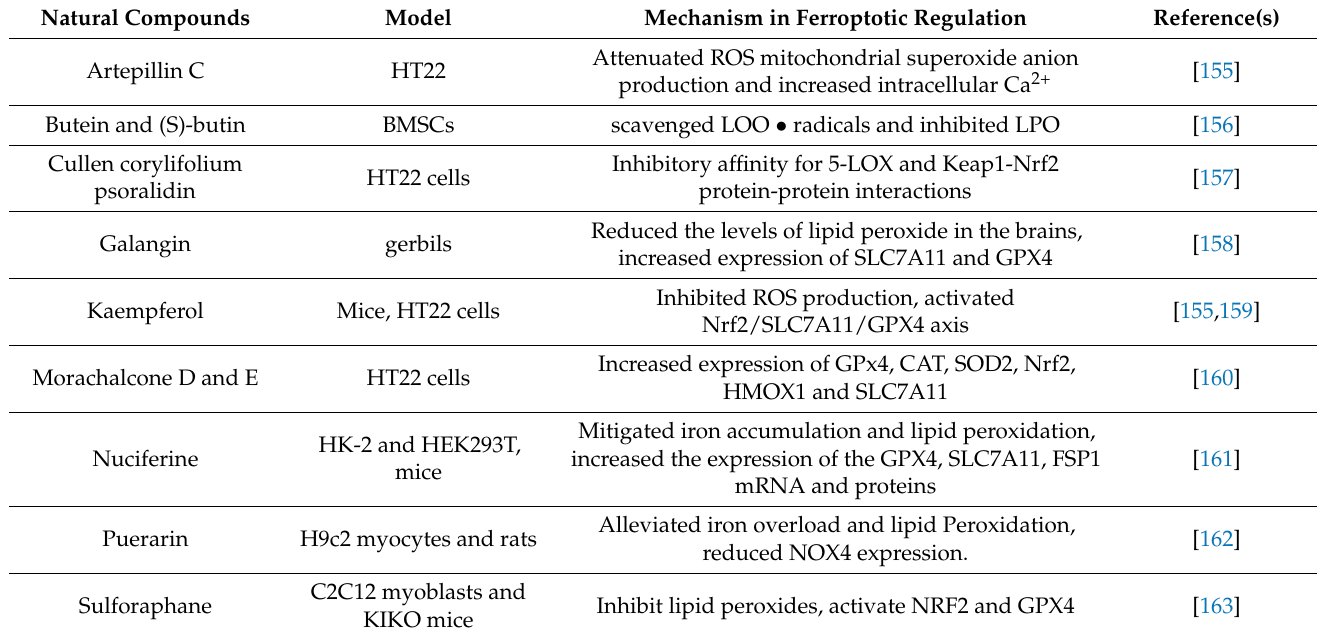
Table 3. The inhibitory effects and mechanisms of natural compounds on